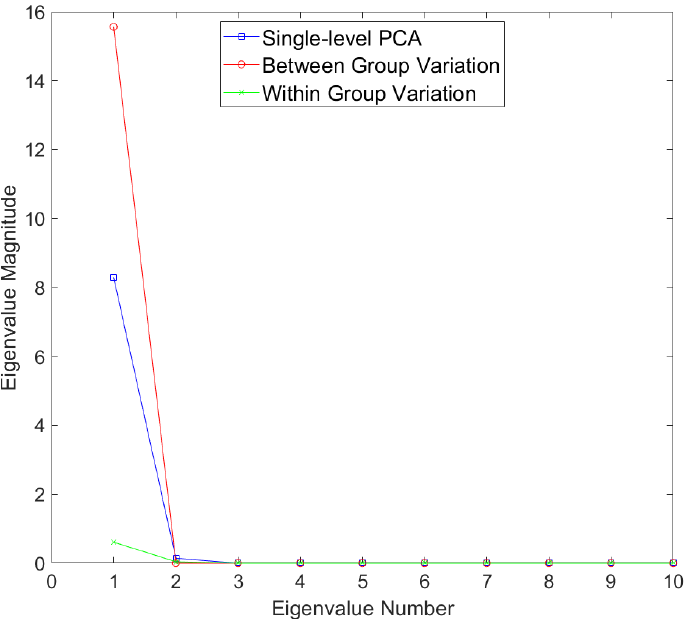
Figure 5. Eigenvalues for single-level PCA and mPCA for between-groups variation (level 1) and within-groups variation (level 2) for the Blink dataset.